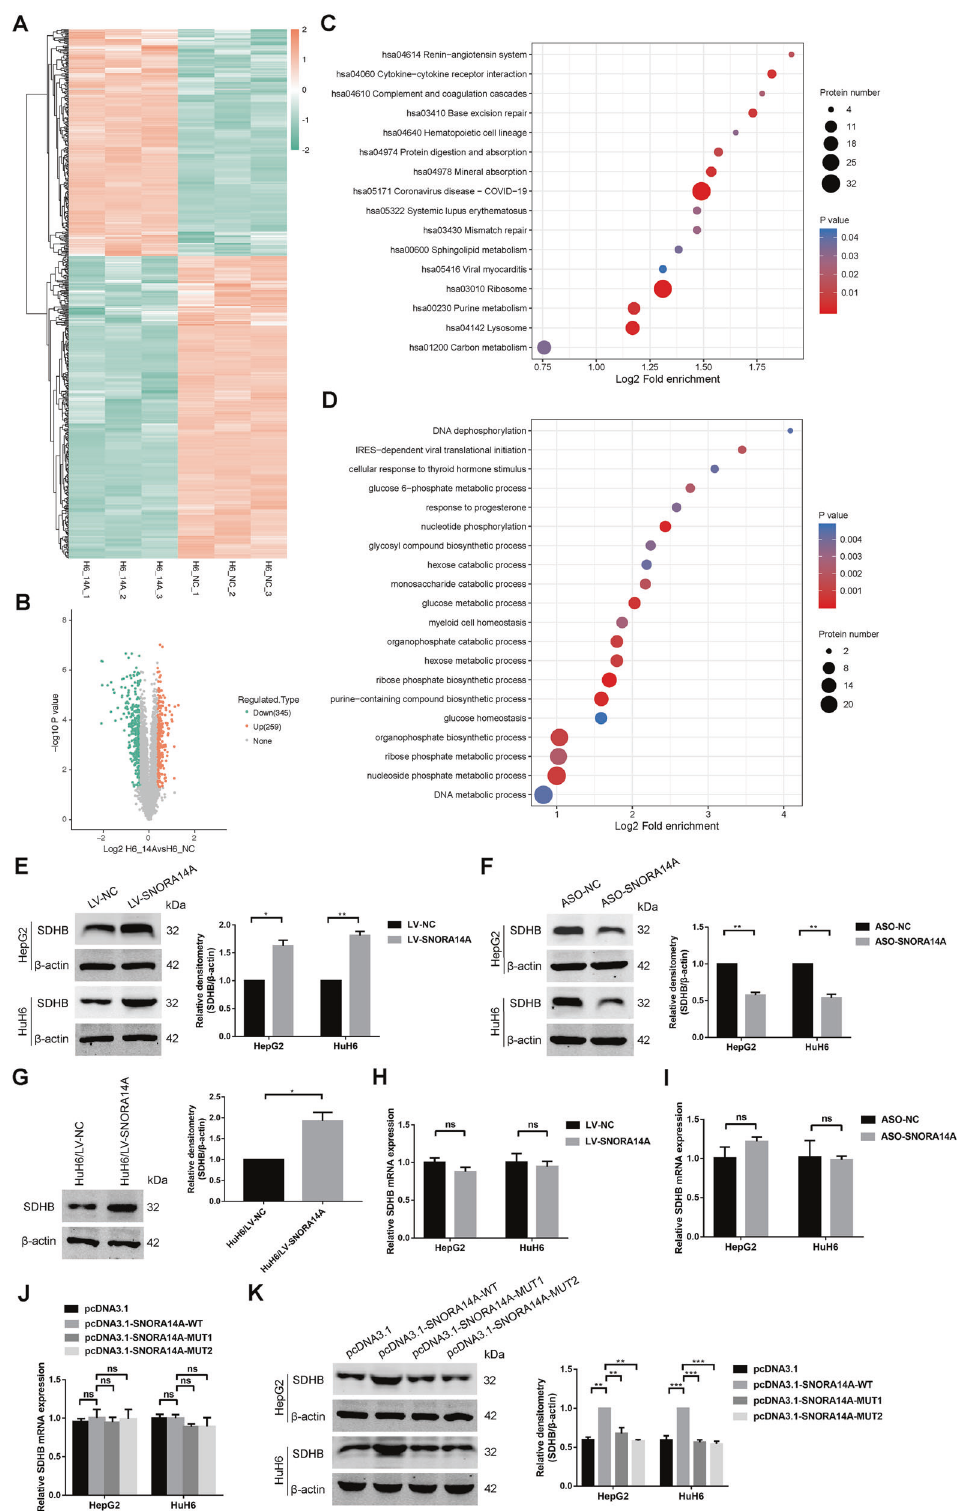
Fig. 5 SNORA14A enhances SDHB protein expression by promoting 18 S rRNA maturation. A Heatmap clustering of TMT-labelled quantitative proteomics conducted in HuH6/LV-NC and HuH6/LV-SNORA14A cells. B , C Volcano plot ( B ) and KEGG pathway enrichment analysis ( C ) of signi fi cantly differentially expressed proteins. D GO enrichment analysis of upregulated proteins. E – G SDHB protein levels in HB/ LV-NC and HB/LV-SNORA14A cells ( E ), cells transfected with ASO-NC or ASO-SNORA14A ( F ) or tumour xenografts ( G ) were measured by Western blotting assays. Relative densitometry was performed with ImageJ. H – J Relative mRNA levels of SDHB in stable HB cells ( H ) or cells with the indicated transfection condition ( I , J ) were measured by qRT ‒ PCR assays. K SDHB protein levels in cells with the indicated transfection condition were measured by Western blotting assays. Relative densitometry was performed with ImageJ.